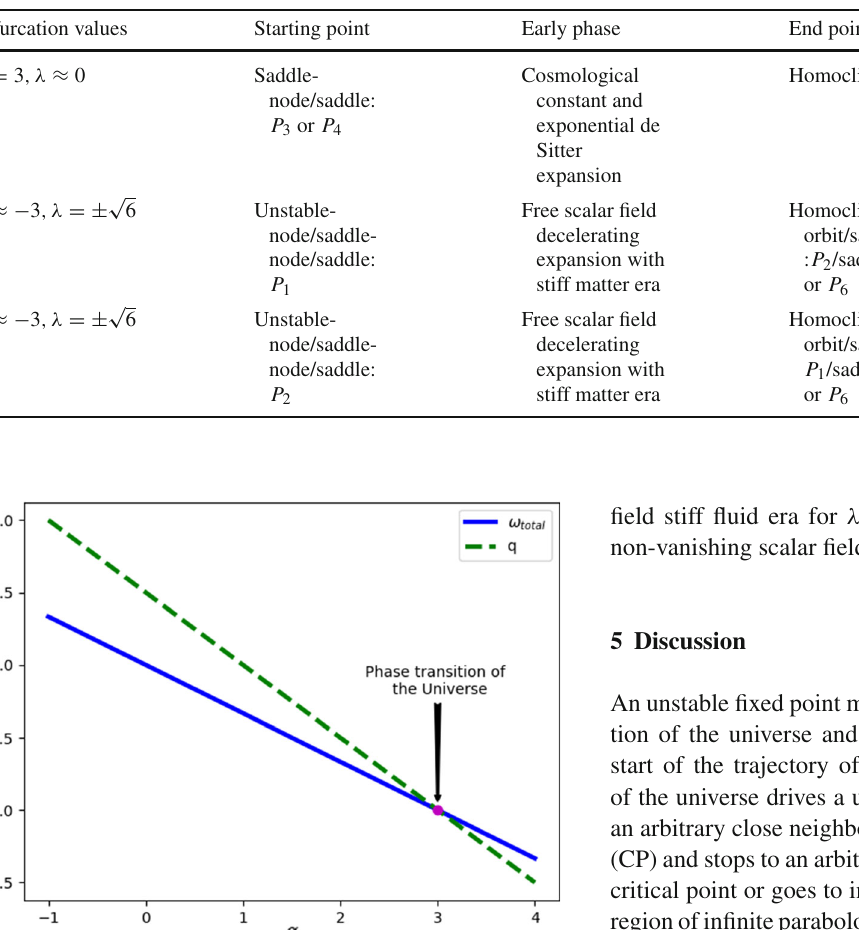
Table 10 Non-generic evolution at bifurcation values